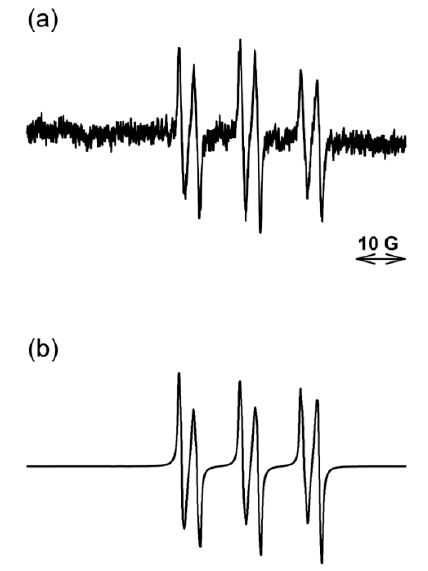
Figure 2. ( a ) EPR spectra of radicals obtained upon the reduction of 7a (17 mM) by the N-terminally truncated (soluble) cytochrome P450 oxidoreductase (sPOR) protein (7 ng mL − 1 ) in a solution at 37 ° C containing diethylenetriaminepentaacetic acid (DETAPAC) (100 uM), superoxide dismutase (300 units mL − 1 ), catalase (1500 units mL − 1 ), glucose-6-phoshate dehydrogenase (13 units mL − 1 ), glucose-6-phosphate (10 mM), NADPH (1 mM) at pH 7 in the presence of N - tert -butyl- α -phenylnitrone (PBN, 0.1 M); ( b ) simulated spectrum (NIH WINSIM) of (i) PBN-C centered species (0.81), and (ii) PBN-aryl 0.19, r = 0.966.